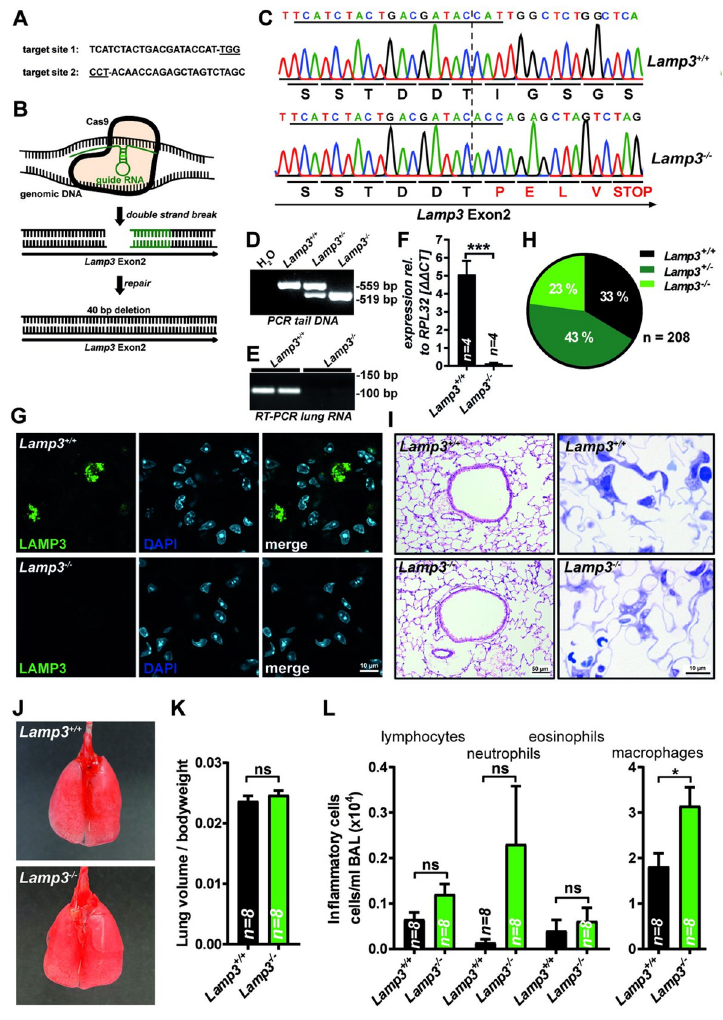
Fig 1. CRISPR/Cas9-mediated knockout of Lamp3 in mice. (A) CRISPR guide-RNA sequences used for targeted editing of the murine Lamp3 allele. The Protospacer Adjacent Motif (PAM) is underlined. (B) Schematic drawing of CRISPR/Cas9-mediated targeting of exon 2 of the Lamp3 locus. (C) Sanger sequencing chromatogram of a PCR- product covering the targeted segment with genomic tail-DNA of one wild type and one homozygous Lamp3 -/- mouse as a template. CRISPR target site one is underlined. The frameshift resulting from endogenous repair mechanisms results in an early stop codon. (D) Agarose gel with PCR-products of a PCR covering parts of exon 2 of the Lamp3 locus used for genotyping. (E) Representative agarose gel with the PCR products of reverse transcriptase reactions with total lung RNA as a template and primers specific for Lamp3 from two wildtype and two Lamp3 -/- mice . (F) Quantitative real-time PCR of total RNA from wildtype and Lamp3 -/- mice for LAMP3. The expression is was normalized to the housekeeping gene RPL32. n = 4 (per genotype); ��� = p � 0.001. (G) Immunohistochemistry staining of lung sections of wildtype and Lamp3 -/- mice with an antibody specific for LAMP3. (H) Genotype distribution of the litters from heterozygote Lamp3 +/— breeding pairs after weaning (3–4 weeks after birth). N = 208 individuals. (I) Left: Hematoxylin / Eosin staining of lung sections from adult wildtype and Lamp3 -/- mice. Right: Toluidine blue staining of plastic-embedded semi-thin sections from adult wildtype and Lamp3 -/- mice. (J) Photos of the inflated lungs of adult wildtype and Lamp3 -/- mice. (K) Lung volume/body weight ratio of wild type and Lamp3 -/- mice. n = 8 (per genotype), ns = not significant. (L) The number of inflammatory cells (lymphocytes, neutrophils, eosinophils, and macrophages) in the BAL of wildtype and Lamp3 -/- mice. n = 8 (per genotype), ns = not significant; 0.05; � = p � 0.05.